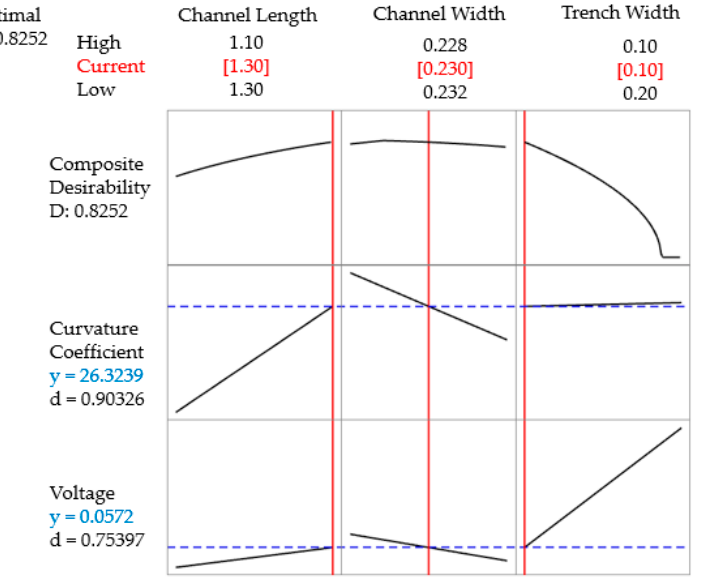
Figure 9. Response optimizer plot for regression analysis using optimized structure of SSD.